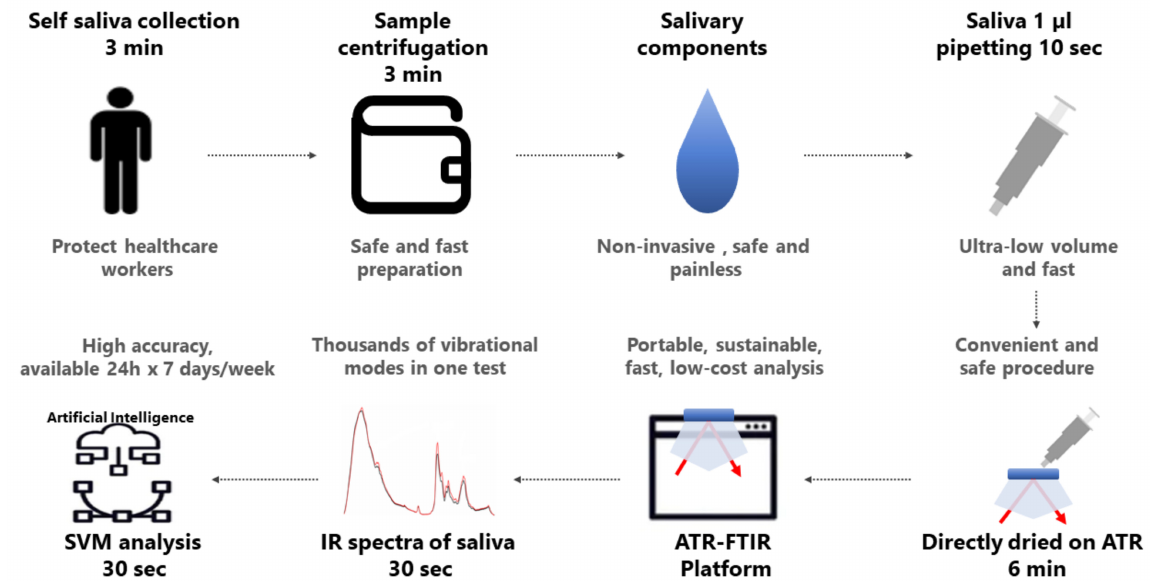
Figure 1. Biophotonic platform for salivary diagnostics of diabetes: proposed workflow for salivary collection and sample preparation; saliva (1 µ L) directly dried on ATR-crystal, infrared acquisition on ATR-FTIR platform and discrimination with machine learning algorithms.